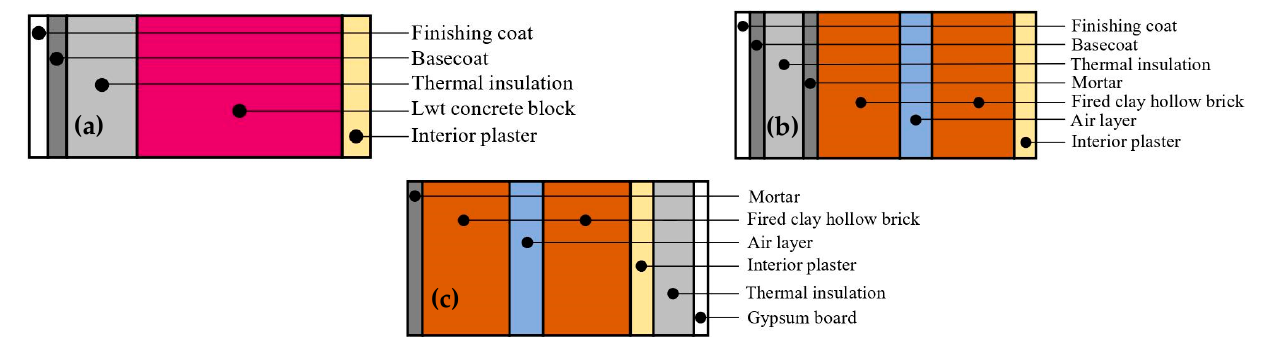
Figure 10. Section view of the studied wall assemblies: ( a ) new construction (NW and ZNW); ( b ) outdoor retrofit (RE); ( c ) indoor retrofit (RI).